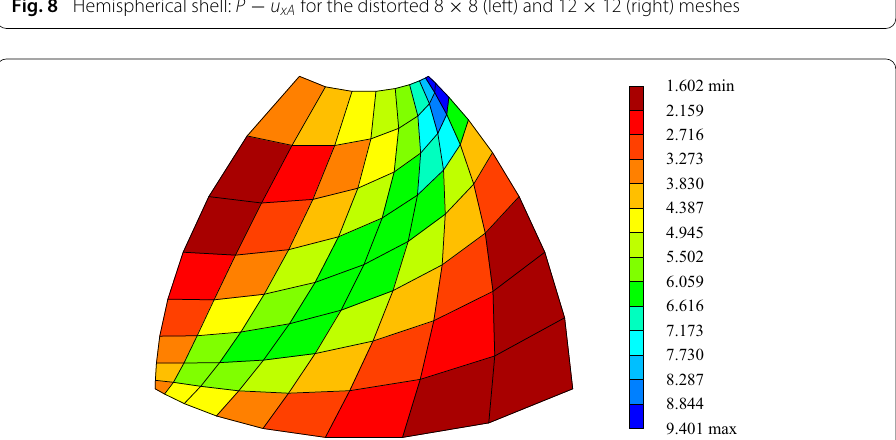
Fig. 8 Hemispherical shell: P − u xA for the distorted 8 × 8 (left) and 12 × 12 (right) meshes